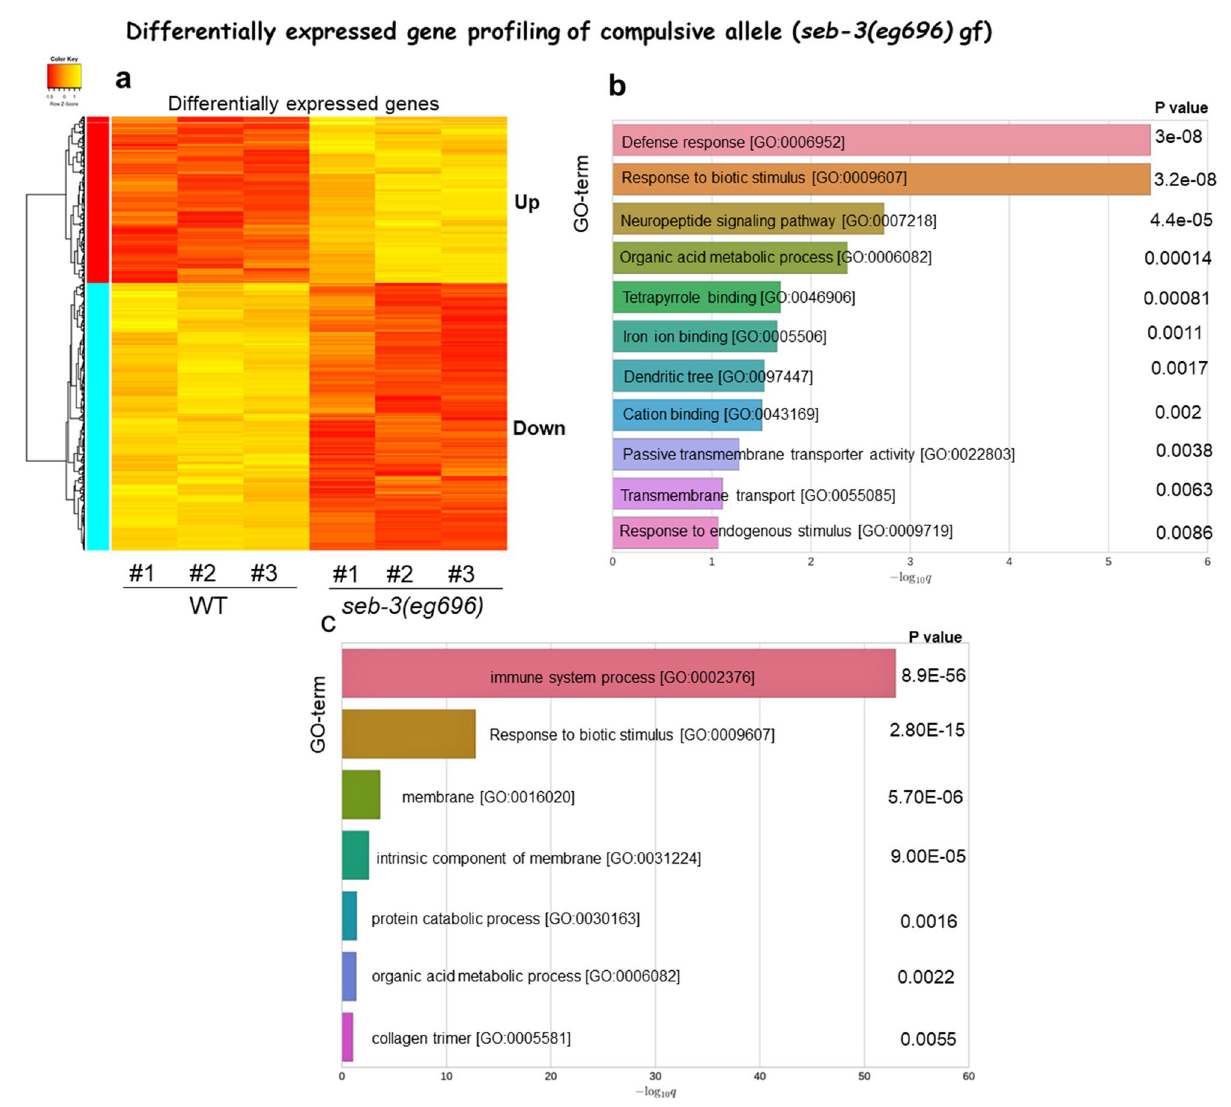
Figure 6. Differentially expressed gene profiling of genetic variant vulnerable to compulsive seeking behavior. ( a ) Altered expression of transcripts in seb-3gf . Gene Ontology (GO) enrichment analysis revealed 11 GO terms that upregulated genes are enriched ( b ) and 7GO terms of downregulated genes ( c proteins, tkr-1, tkr-2 , and tkr-3 as shown in the phylogenetic analysis of the Tachykinin/Neurokinin Receptor family (Fig. 7b). The phylogenetic tree was constructed by COBALT (constraint-based alignment tool for multiple protein sequences) using minimum evolution method 25 . We also tested KO mutant animals of tkr-2 (ok1620) and tkr-3(ok381) in the neurokinin receptor family. The tested are putative KO strains due to the deletion of genomic loci (Fig. 7d–f). The evident phenotype was observed in tkr-1 (ok2886) animals. A Fig. 7d showed significantly low SI values of tkr-1 KO compared to WT animals in ethanol seeking assay against the Cu 2+ barrier in overall concentrations. Remarkably, tkr-1 KO animals did not cross even low concentration of Cu 2+ barrier after ethanol pretreatment like seb-3 KO animals. Interestingly, the KO animals of tkr-2, predicted as a NK3R orthologue 18 , also showed slightly reduced development of aversion-resistant ethanol seeking induced by ethanol pretreatment whereas tkr-3 KO animals displayed ethanol preference and aversion-resistant ethanol seeking as much as wild type (Fig. 7e,f). Furthermore, epistatic analysis demonstrated that compulsive ethanol seeking in seb-3(eg696) gf animals was suppressed by KO in the tkr family, tkr-1 and tkr-2 (Fig. 7g,h). It suggests that TKR-1 and TKR-2 function downstream of SEB-3 with redundancy in the family (Fig. 7g,h, and Sup. 5). TKR-1 is expressed in the glial cells such as AMsh and sensory/interneurons such as URA (or CEP), ASJ, and AIY confirming the expres- sion in the consortium data (Fig. 8a and 79 ). This promoter and the genomic tkr-1 could rescue the tkr-1 KO phenotype (Fig. 8b). Neural processes in worms are surrounded by glial cells such as AMsh 80 . Growing evidence shows C. elegans glial-neuron interactions are involved in the regulation of animal behavior such as olfaction, gustation, and thermosensation 81 . Indeed, NK1R is expressed in human glia cells and functionally respond to its ligand 82 . AMsh, in which neurons such as AWC, which are expected to be involved in ethanol seeking, and nociceptive neurons, such as ASH and ADL, are simultaneously connected through adhesive junctions. Along